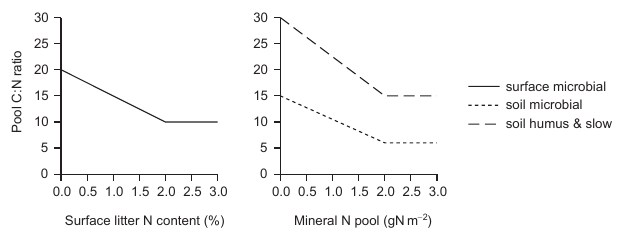
Fig. C2. Determination of target C:N ratio of receiver pools in SOM flux transfer scheme (Parton et al., 1993,